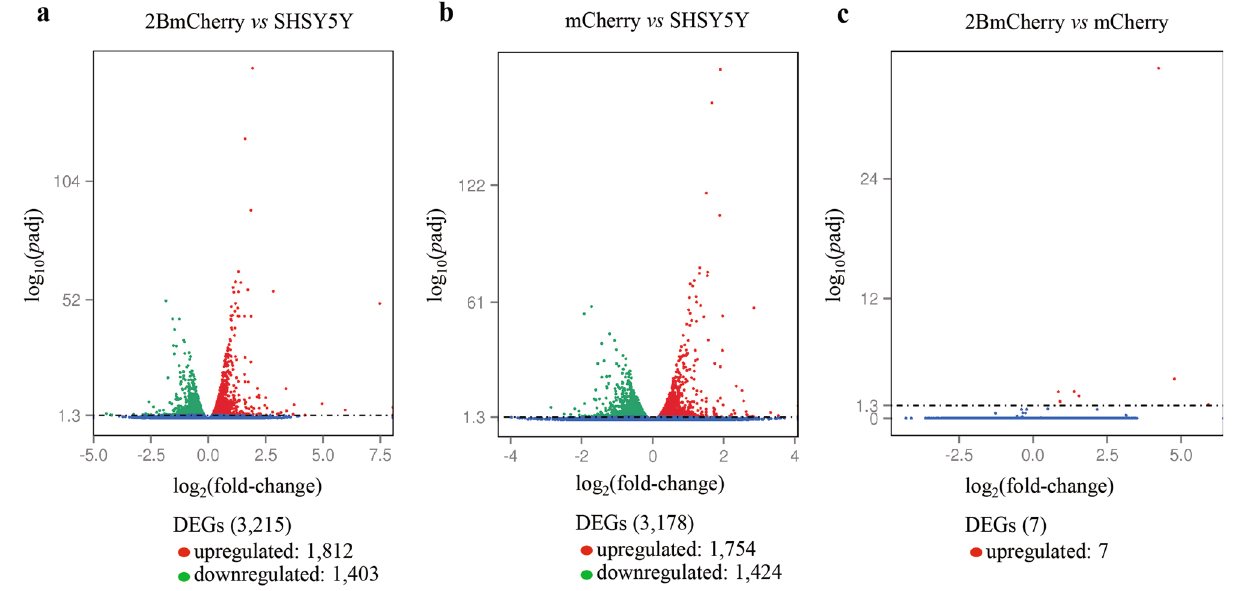
Figure 1. Volcano plots of the differentially expressed genes (DEGs) in each comparison group including 2BmCherry versus SHSY5Y transcriptome ( a ) mCherry versus SHSY5Y transcriptome ( b ), and 2BmCherry versus mCherry transcriptome ( c ). The x -axis represents the magnitude of statistical significance. The y -axis indicates the magnitude of change. The dash line indicates a threshold of significant magnitude at -log 10 ( p- adj) = 1.3 or p -adj <